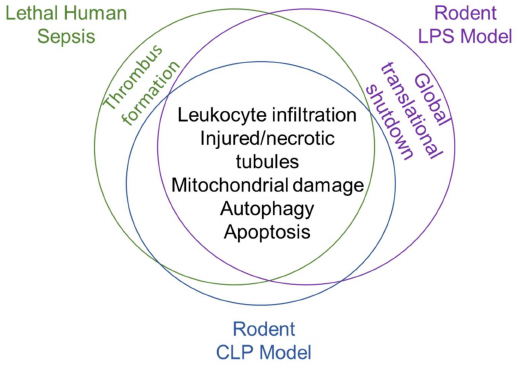
Figure 2. Shared pathological features of lethal human sepsis and rodent preclinical models of